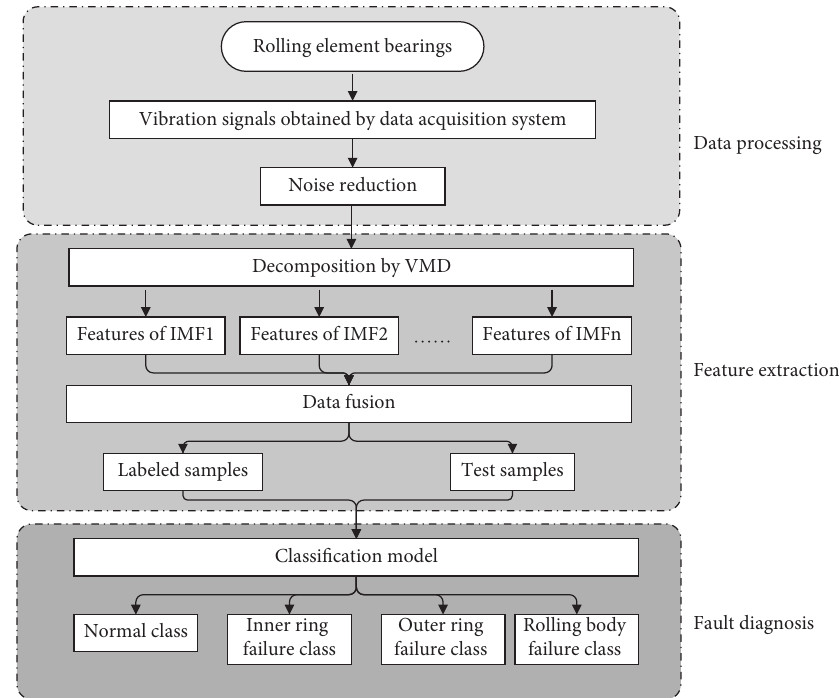
Figure 3: The flowchart of the proposed method.